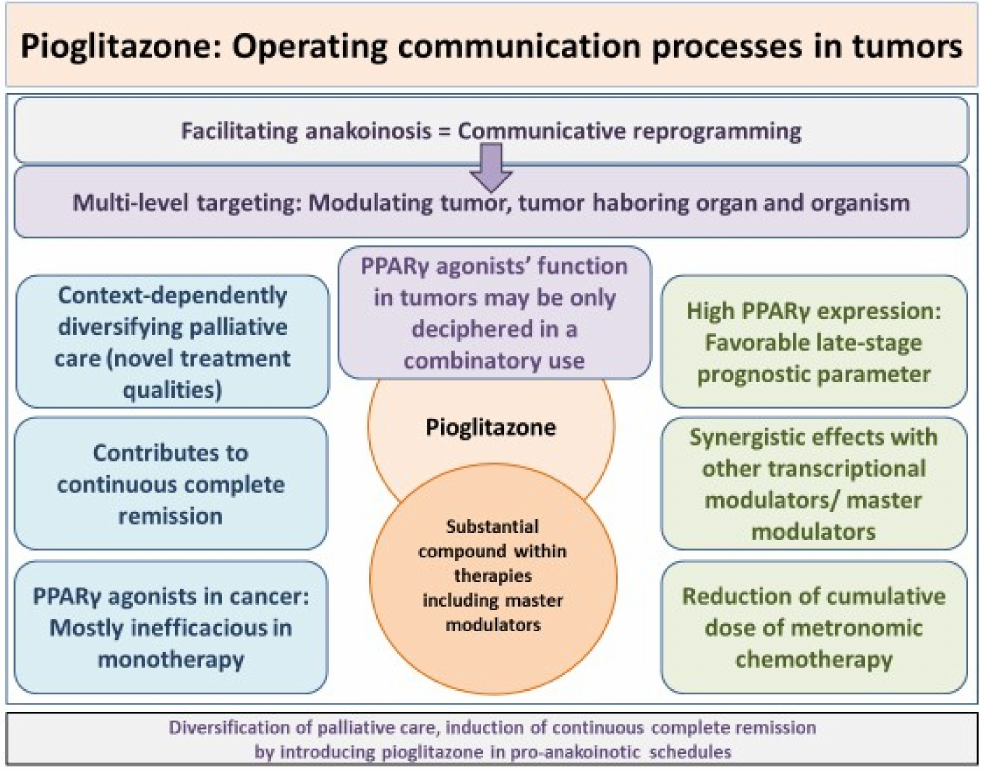
Figure 2. Pioglitazone, operating communication processes in tumors: Clinical